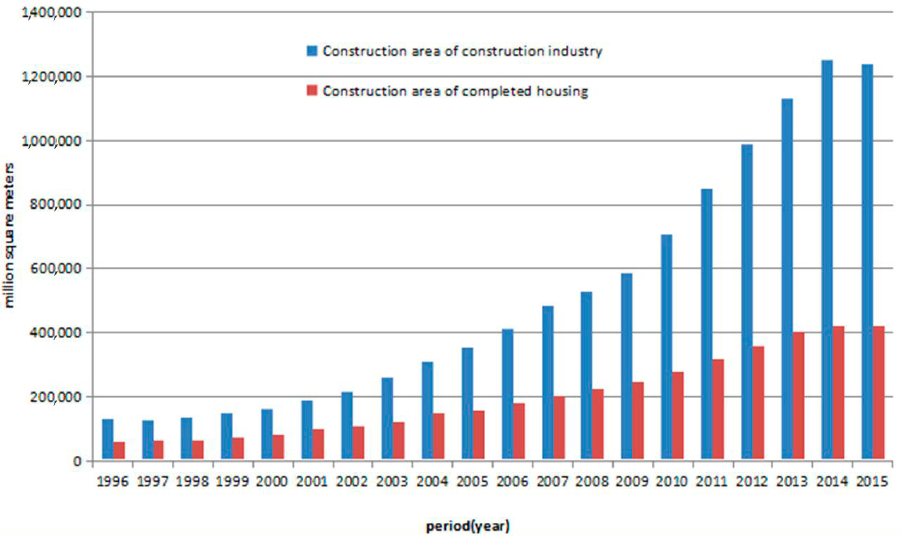
Figure 2. Construction area of the construction industry and completed housing in China from 1996 to 2015.